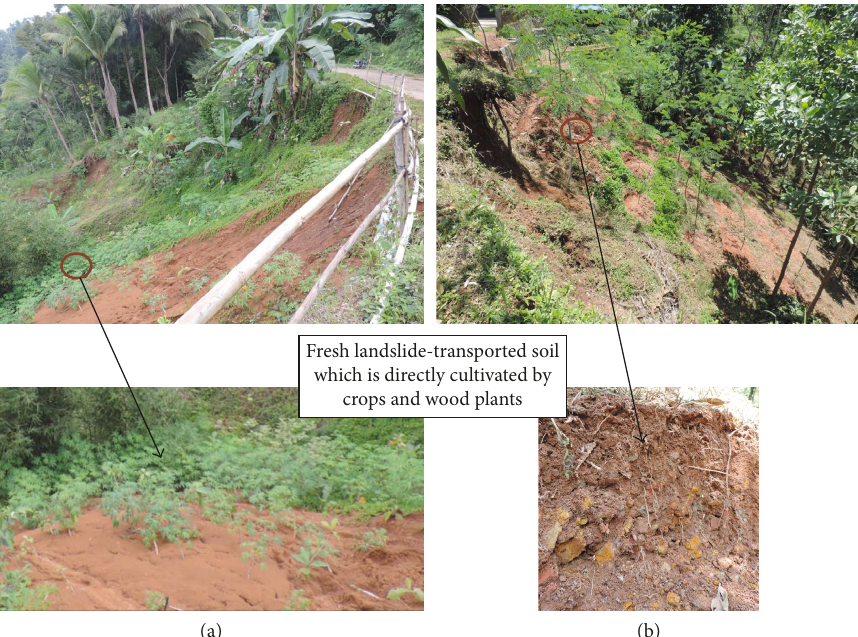
Figure 3: Cultivated landslide-redistributed soil materials: (a) unconsolidated landslide-redistributed soil materials; (b) mixed landslide- redistributed soil